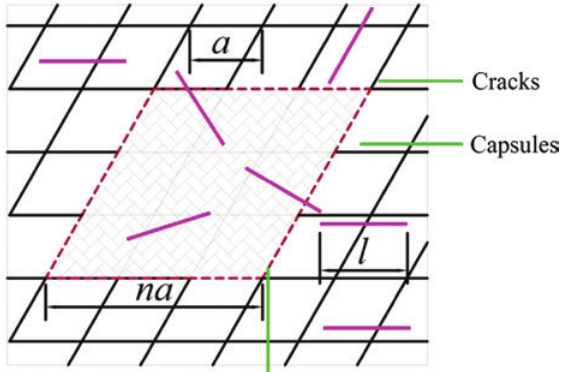
Figure 5: Hexagonal crack pattern and a representative sampling regio n E 3.